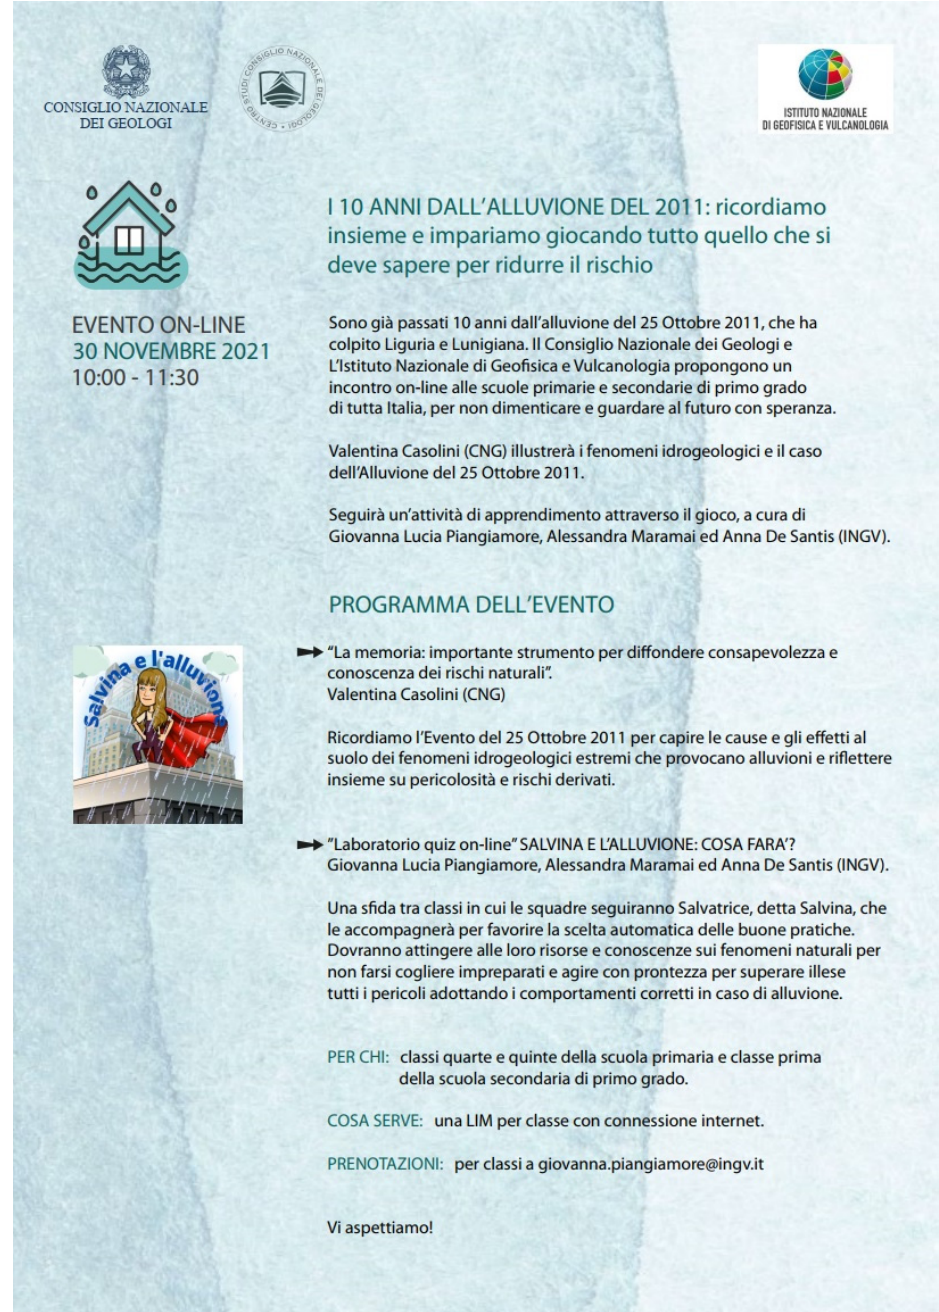
Figure 3. Poster promoting the Salvina and the flood , played online at the event “10 Years after the 2011 flood: let’s remember together and learning by playing how to reduce hydrological